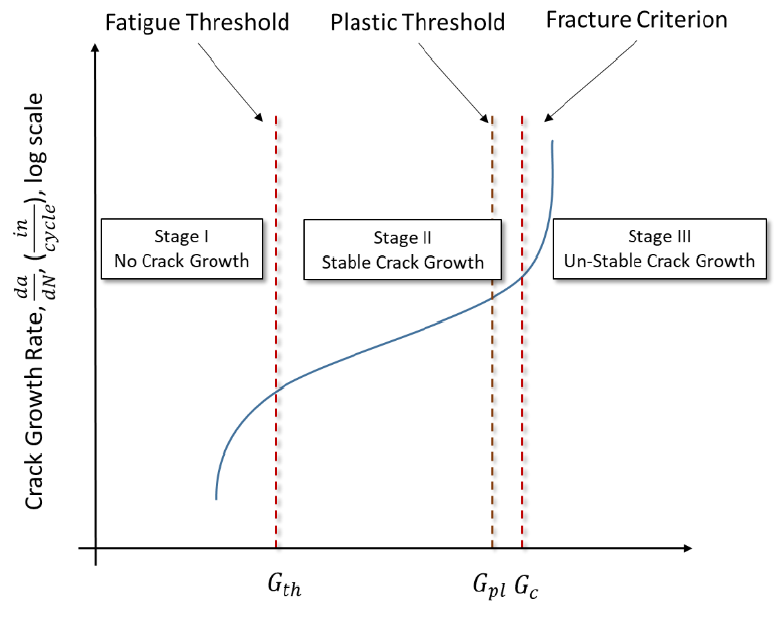
Figure 1. Energy release rate crack growth stages.